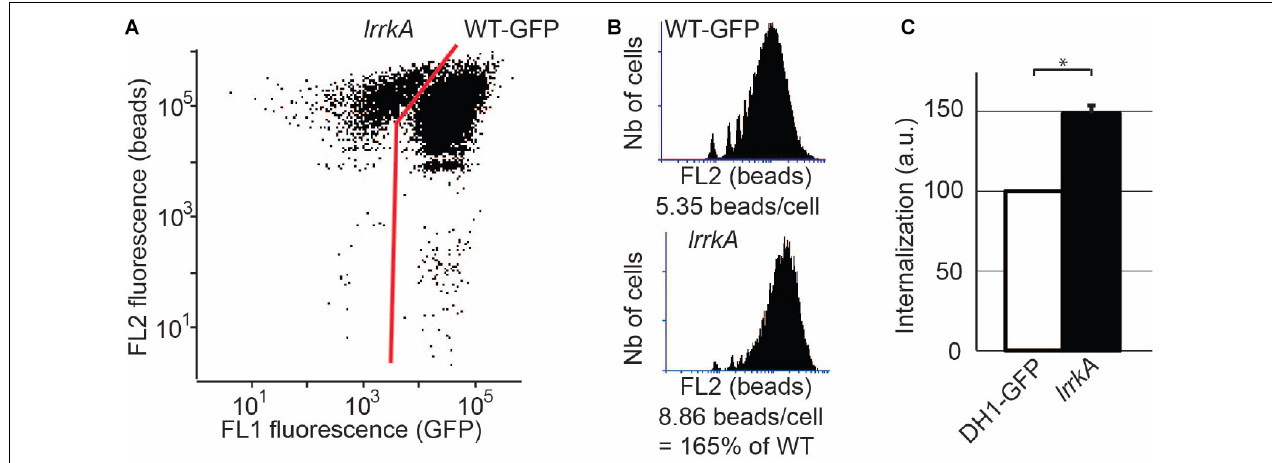
FIGURE 2 | The phenotype of lrrkA KO cells is cell-autonomous. WT cells expressing GFP were mixed with lrrkA KO cells and co-cultured for 6 days. The mixed population of cells was then incubated with rhodamine-labeled polystyrene beads for 20 min, washed, and analyzed by flow cytometry. (A) Based on the GFP fluorescence, WT cells were easily distinguished from lrrkA KO cells. (B) Phagocytosis of beads was determined for WT and lrrkA KO cells. Even when mixed with WT cells, lrrkA KO cells exhibited more phagocytic activity than WT cells. In the experiment shown, lrrkA KO cells ingested 1.65 times more beads than WT cells. (C) The single experiment shown in A and B was repeated and quantified ( ∗ p < 0.01, Mann–Whitney test; N = 6 independent experiments).